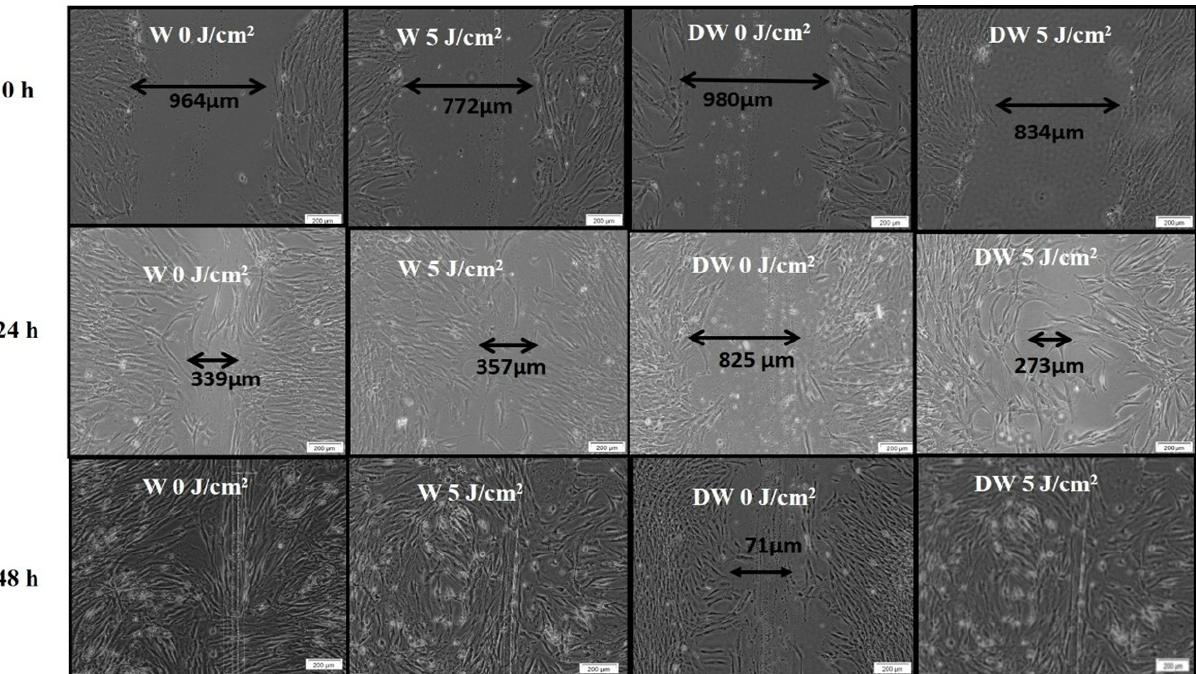
Figure 1. Micrographs depicting cell migration towards the centre of the central scratch as assessed by inverted microscopy at 0 h, 24 h, and 48 h following irradiation at a wavelength of 660 nm, with 5 J/cm 2 in non-irradiated and irradiated wounded (W) and diabetic wounded (DW) cells. Table 2. Average distance of three repeats of the wound length in µm in wounded (W) and diabetic wounded (DW) cell models (n = 3). Significant probability related to non-irradiated (0 J/cm 2 ) control cells at the same time-point is shown as * p ≤ 0.05 (SEM). Significant probability related to 0 h within cell models is shown as † p ≤ 0.05 and †† p ≤ 0.01 .